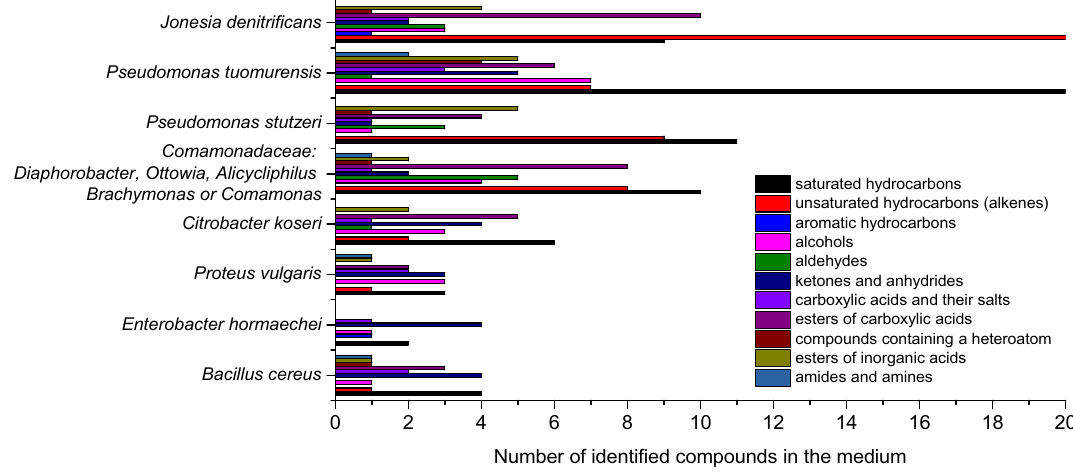
Fig. 6 Overview of the groups of biodegradable compounds found in the medium after degradation with all tested bacterial